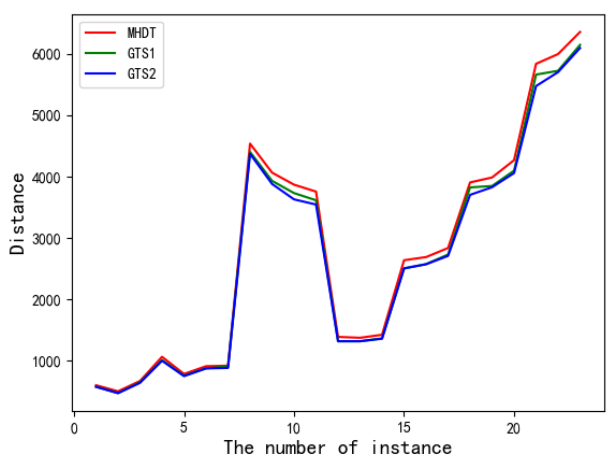
Figure 13. Among three algorithms about Figure 13. among three algorithms about Distance.